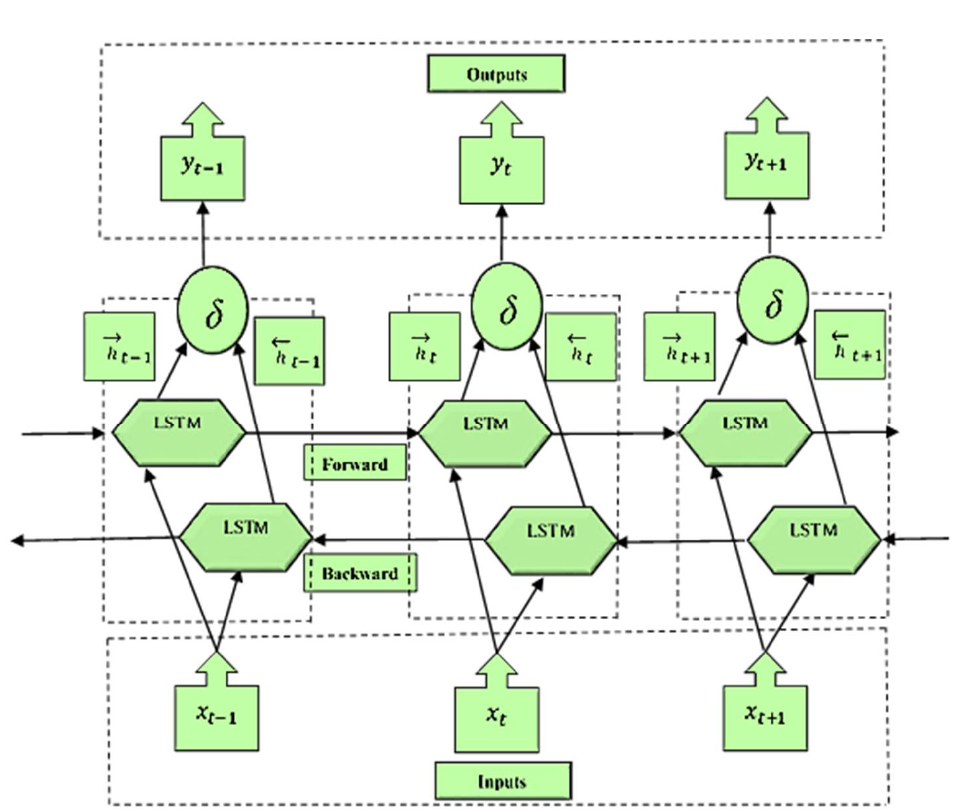
Figure 8. The BiLSTM architecture showing the network and the forward and backward LSTM lay- ers.